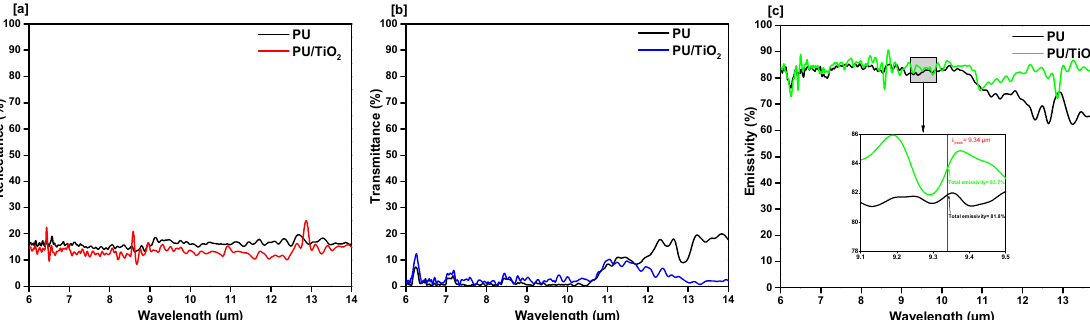
Figure 5. FIR property characterization of titanium dioxide incorporated PU films. FTIR measured ( a ) reflectance, ( b ) transmittance, ( c ) emissivity.